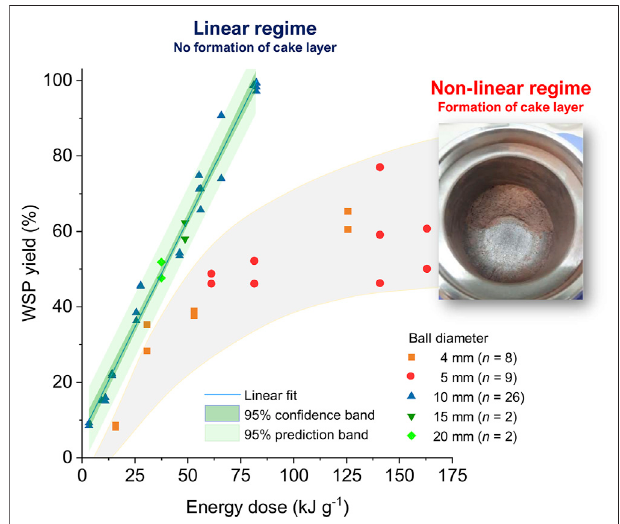
FIGURE 2 | DependenceofWSPyield onthekineticenergydoseprovided to H 2 SO 4 -impregnated beechwood by the planetary mill (Pulverisette seven premium, Fritsch) employing varied conditions as listed in Supplementary Table S1 . Unlike the regions presented in green tones, which represent the 95% con fi dence band and 95% prediction band, the region highlighted in gray is solely intendedtoserveasaguidefortheeyes,qualitatively outliningthedatadispersion for the results obtained from MCD in the non-linear